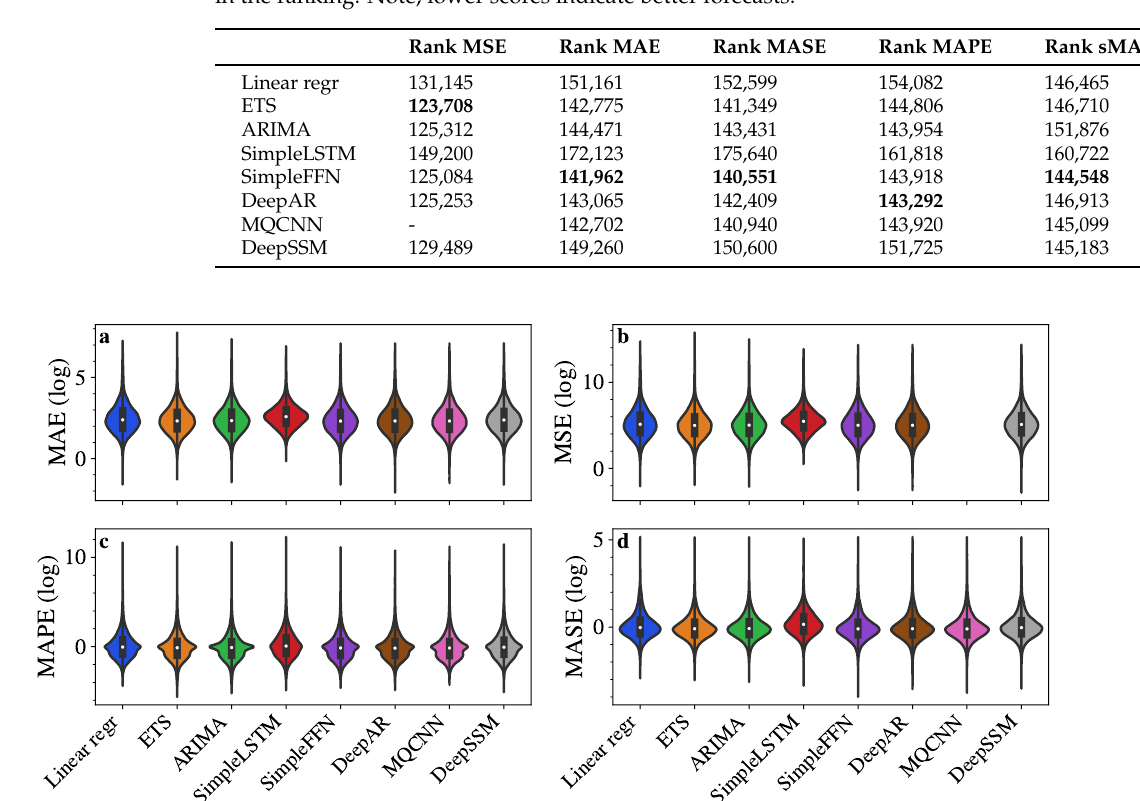
Table 2. Forecast rank per error measure and evaluated method. The score is derived by ranking all generated forecasts, from best to worst performance, and computing the sum of scored ranks per method. Only error measures which were calculated at individual time-series level could be included in the ranking. Note, lower scores indicate better forecasts.